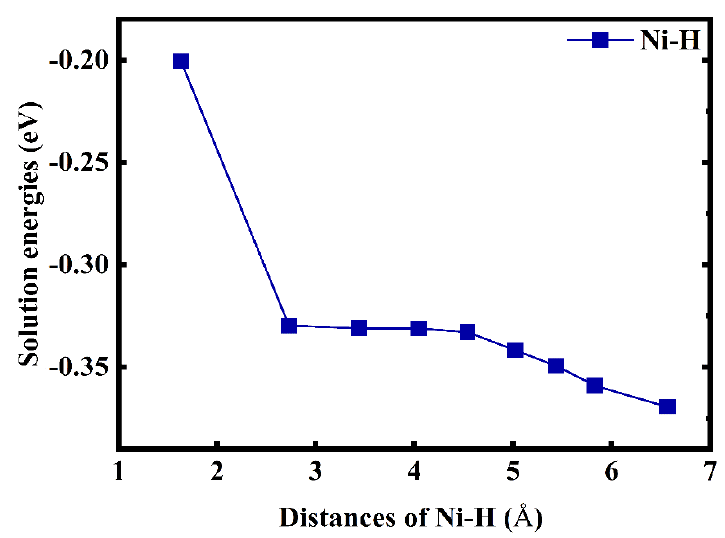
Figure 2. Solution energies of H atom as a function of the Ni–H distances in TIS of V–Ni solid solution alloy.